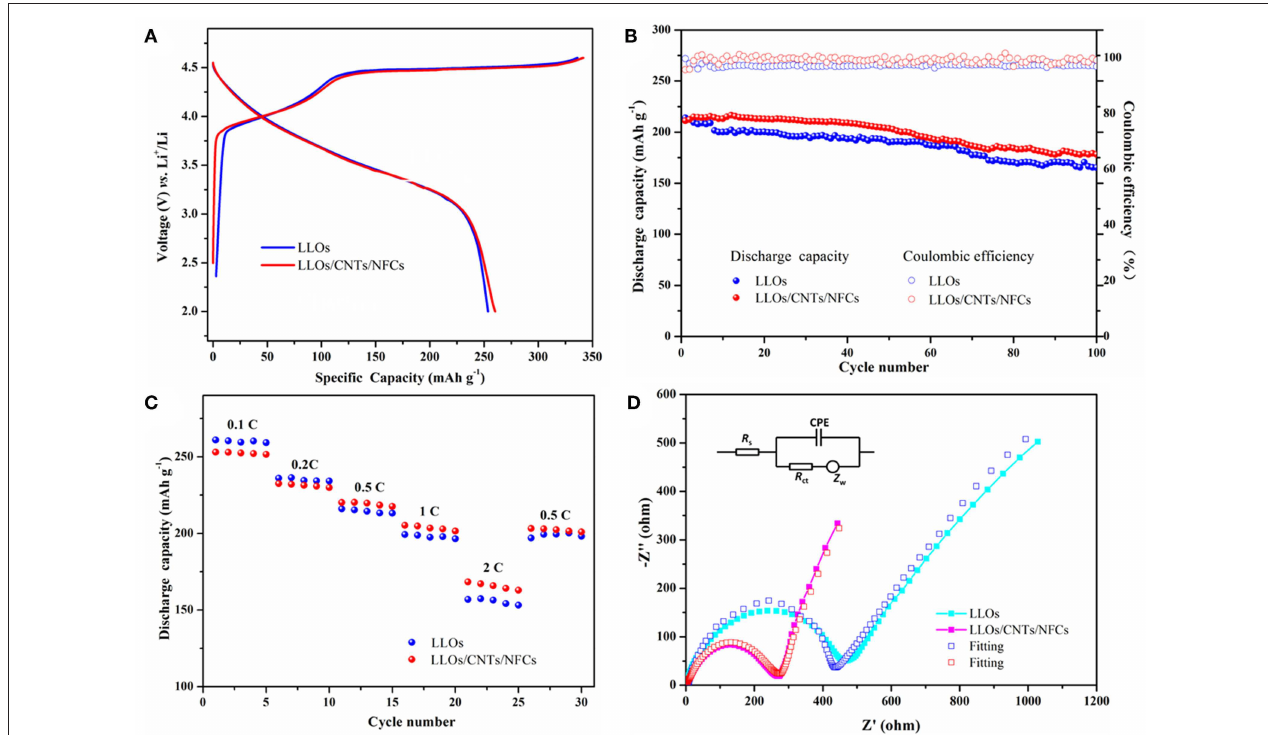
FIGURE 4 | Electrochemical performances of the traditional LLOs electrode and LLOs/CNTs/NFCs electrode: (A) initial charge–discharge profiles at 0.1C rate; (B) Cycle performances at 1C rate and the corresponding Coulombic efficiency; (C) Rate performances in the rate range of 0.1–2C; (D) EIS plots of two samples.